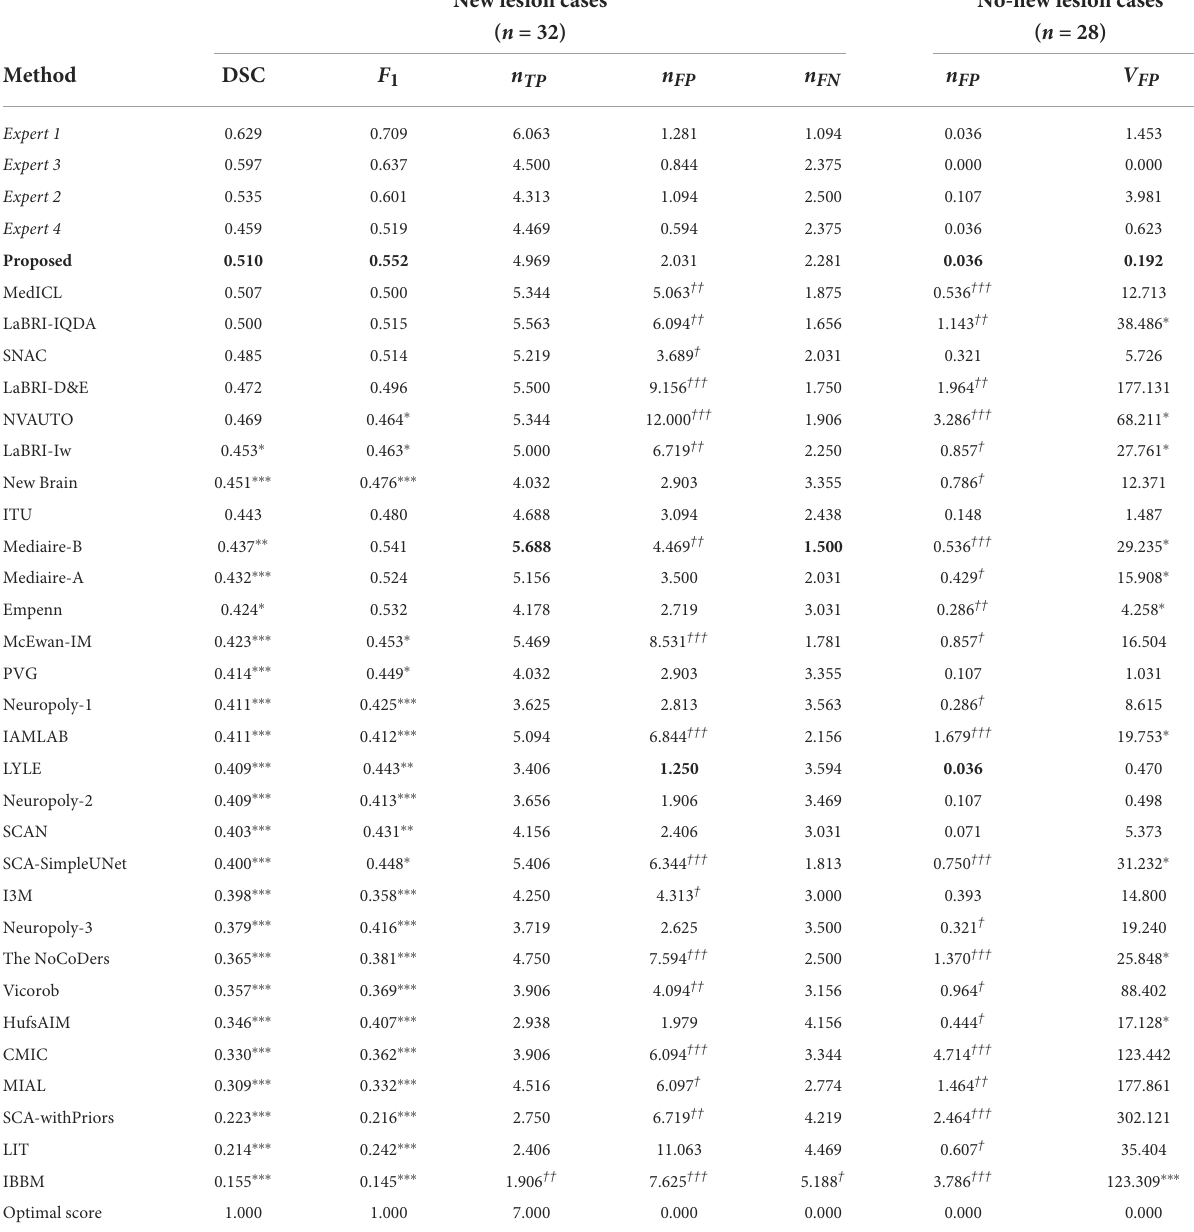
TABLE 1 Comparison of the proposed method to the challenge participating methods in terms of DSC, F 1 scores, the number of true positive lesions n TP , the number of false positive lesions n FP , the number of false negative lesions n FN , and volume of false positive lesions V FP (unit: mm 3 ), averaged across